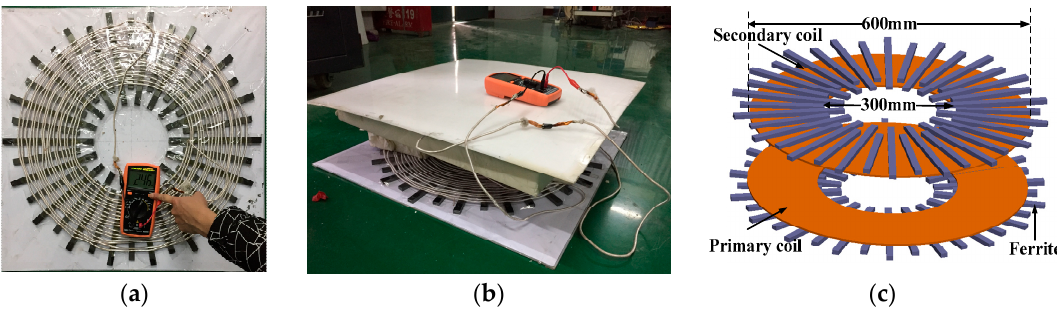
Figure 6. Parameters acquisition ( a ) Self-inductance; ( b ) Mutual inductance ( c ) ANSYS simulation.